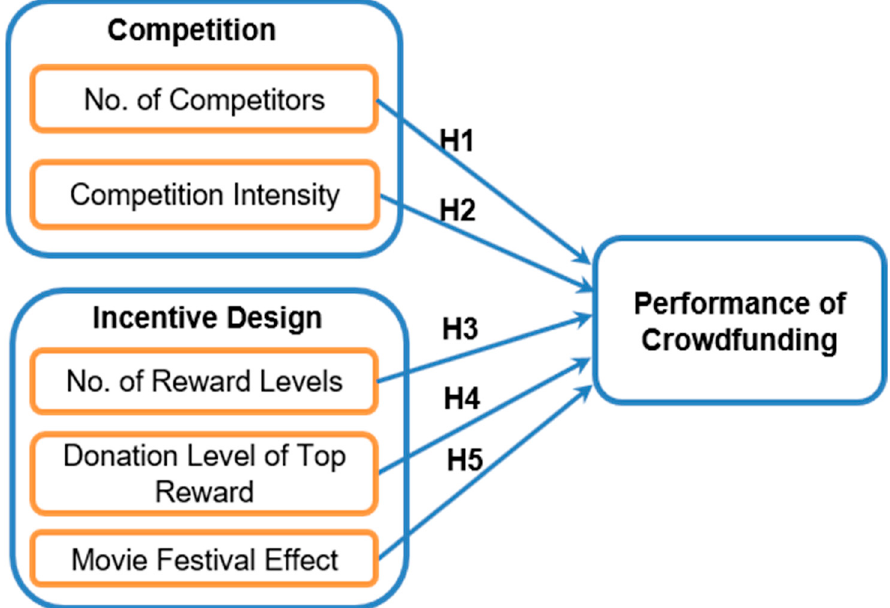
Figure 1. Conceptual Model.